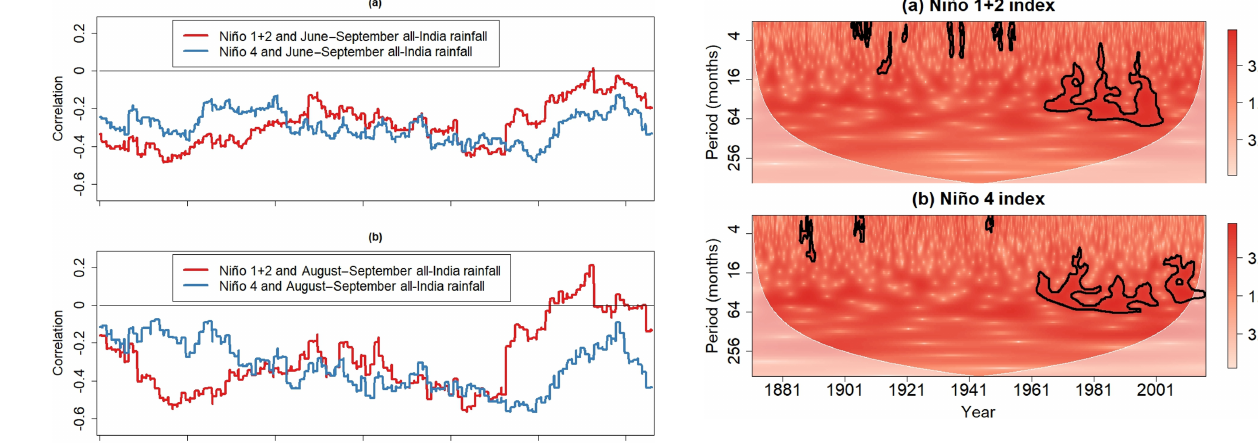
Figure 6. Wavelet power spectrum of the (a) Niño 1 and 2 and (d) Niño 4 indices. Contours enclose regions of 5% cumulative area-wise significance. The shaded region represents the cone of influence, which is the region where edge effects are